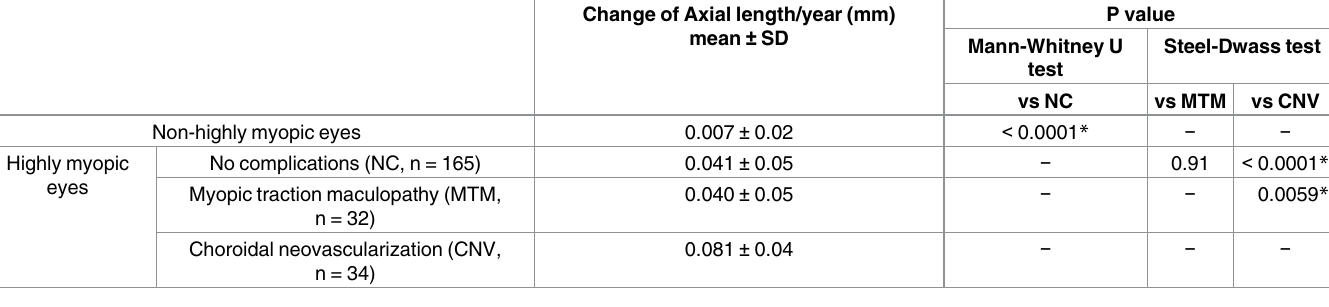
plications group], P = 0.0059 [vs. MTM group]), and no significant difference was found between the no complications and MTM groups (P = 0.91) (Table 5). Table 5. Comparison of the changes in the axial length per year between non-highly myopic eyes and highly myopic eyeswith no complications and between highly myopic eyes with myopic traction maculopathy, choroidal neovascularization, and no complications. Change of Axial length/year (mm) mean ± SD